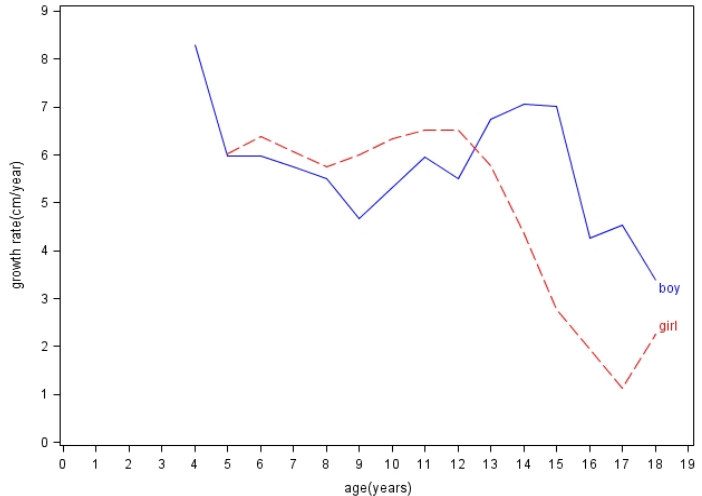
Figure 4. The annual body height growth rates (cm/year) of both genders at different ages.